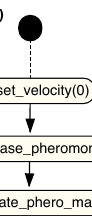
Figure 9. State diagram for the SEPHE behavior of beacon individuals. In each processing step, any individual in this role will execute the steps listed in the